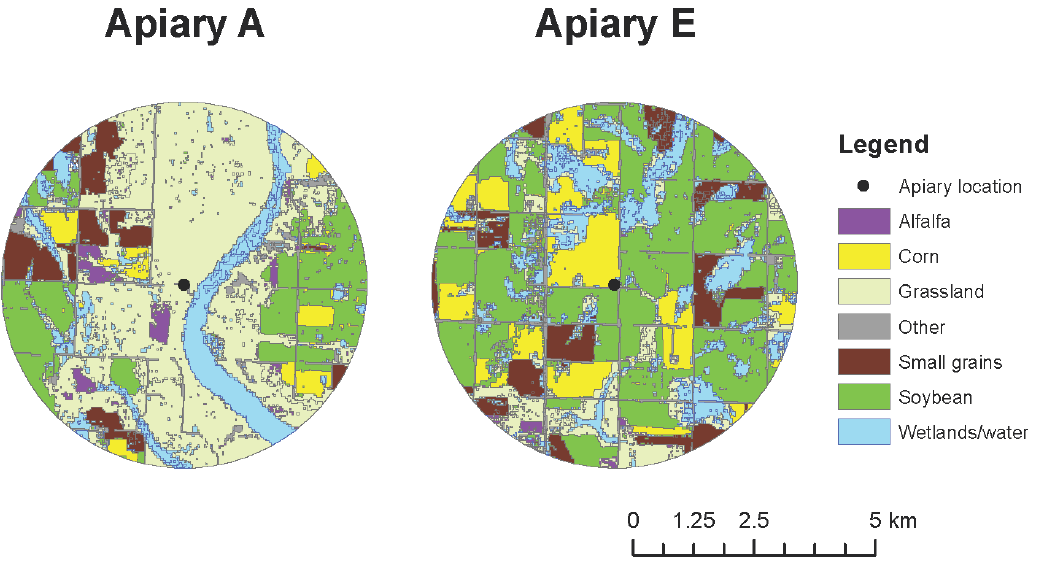
Figure 1. Location and land use surrounding study apiaries, A and E, in 2014.